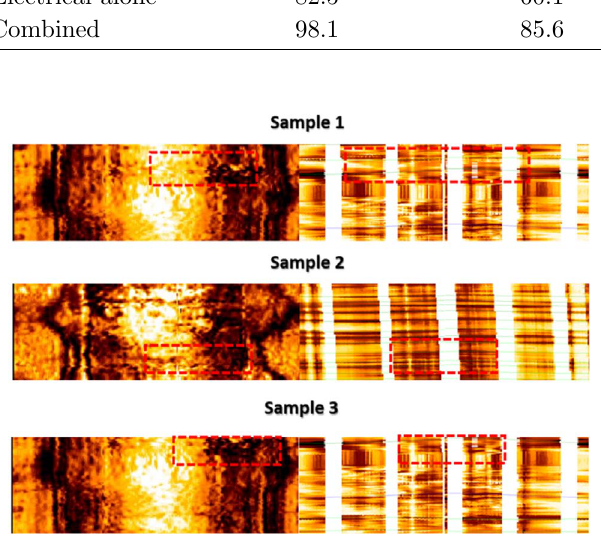
Figure 6. Features in images indicating the presence of